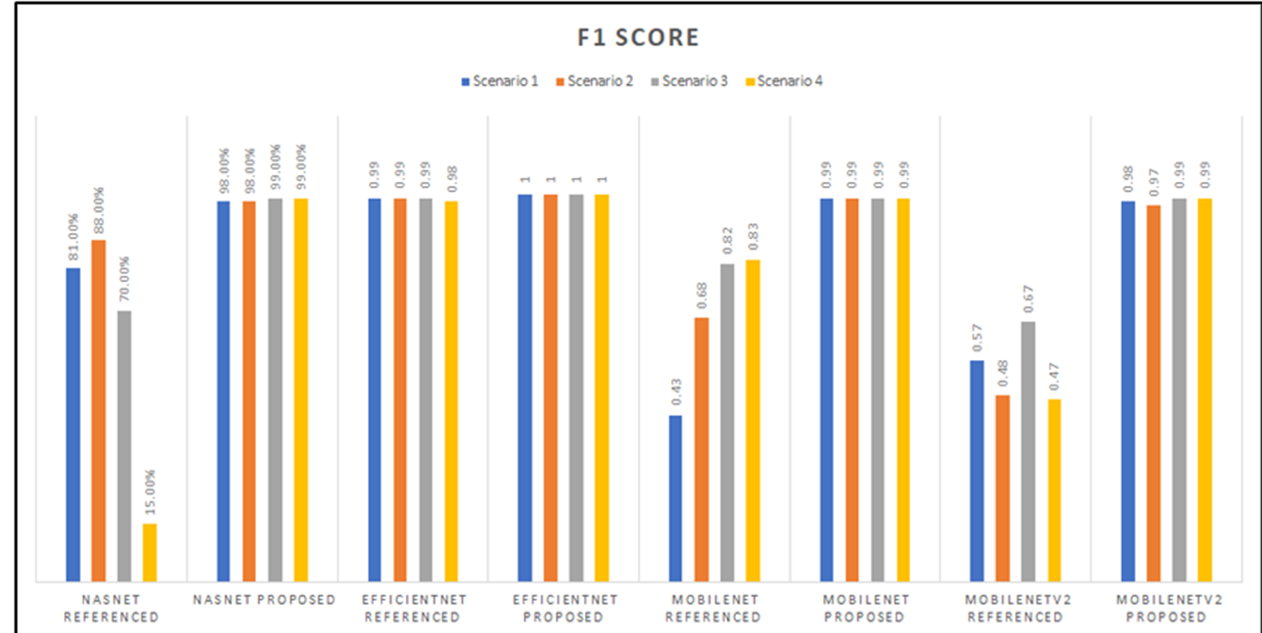
Figure 14. Graphed results of recall scores for all models developed.